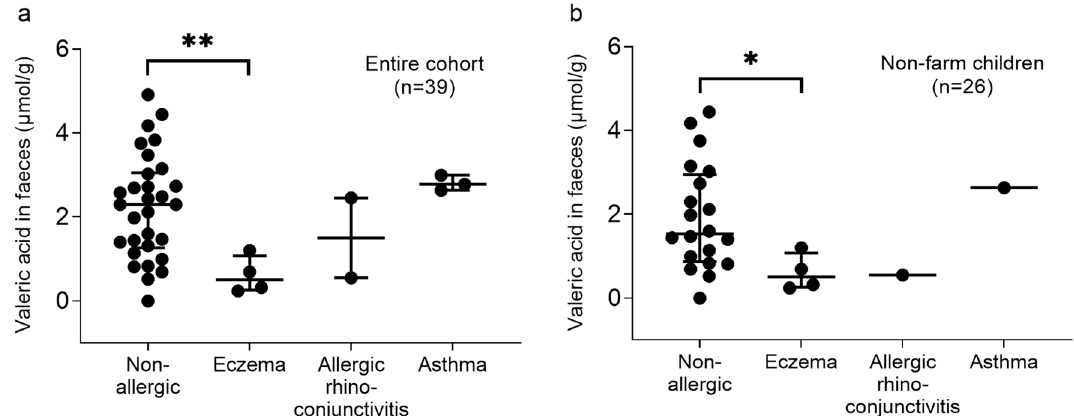
Figure 3. Fecal valeric acid levels at 3 years of age in relation to allergic manifestation at 8 years of age. In ( a ) the whole cohort (n = 39), including both farm and non-farm children, are shown, while ( b ) shows control children only (n = 26). Non-allergic children were defined as having no allergy at 8 years of age. * P < 0.05, ** P < 0.01, Mann–Whitney U-test. Vertical bars show the median and inter-quartile